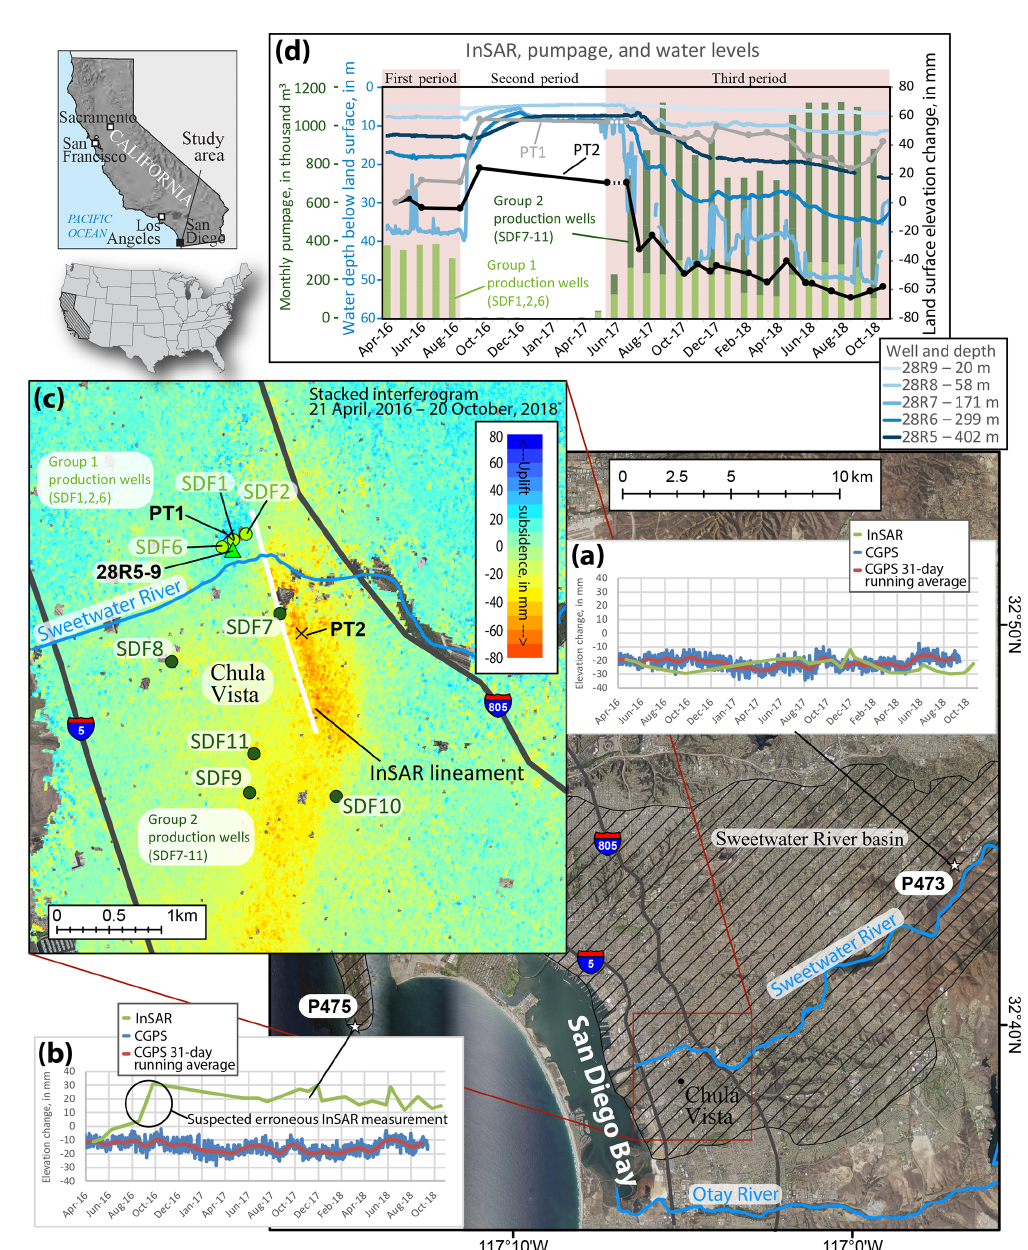
Figure 1. Study area showing Continuous GPS (CGPS) sites, highways, rivers, and Sweetwater River basin, San Diego, California, USA; (a) Continuous GPS (CGPS) and InSAR time series relative to first CGPS data point at P473; (b) CGPS and InSAR time series relative to first CGPS data point at P475; (c) stacked interferogram for 21 April 2016–20 October 2018 (excluding 22 May–27 June 2017) with wells, InSAR time series locations, and InSAR detected lineament; and (d) InSAR timeseries, monthly pumpage volumes and water levels. Sweetwater River Basin modified from Danskin and Church (2005). Basemap is NAIP imagery from 2014, Universal Transverse Mercator projection, zone 11N, North American Datum of 1983 (NAD